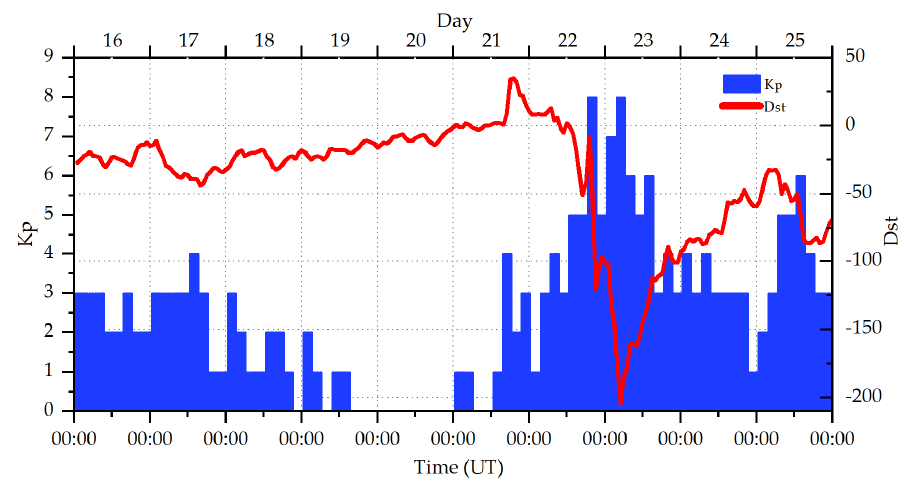
Figure 3. Study area and the distribution of GNSS stations and ionosonde stations.